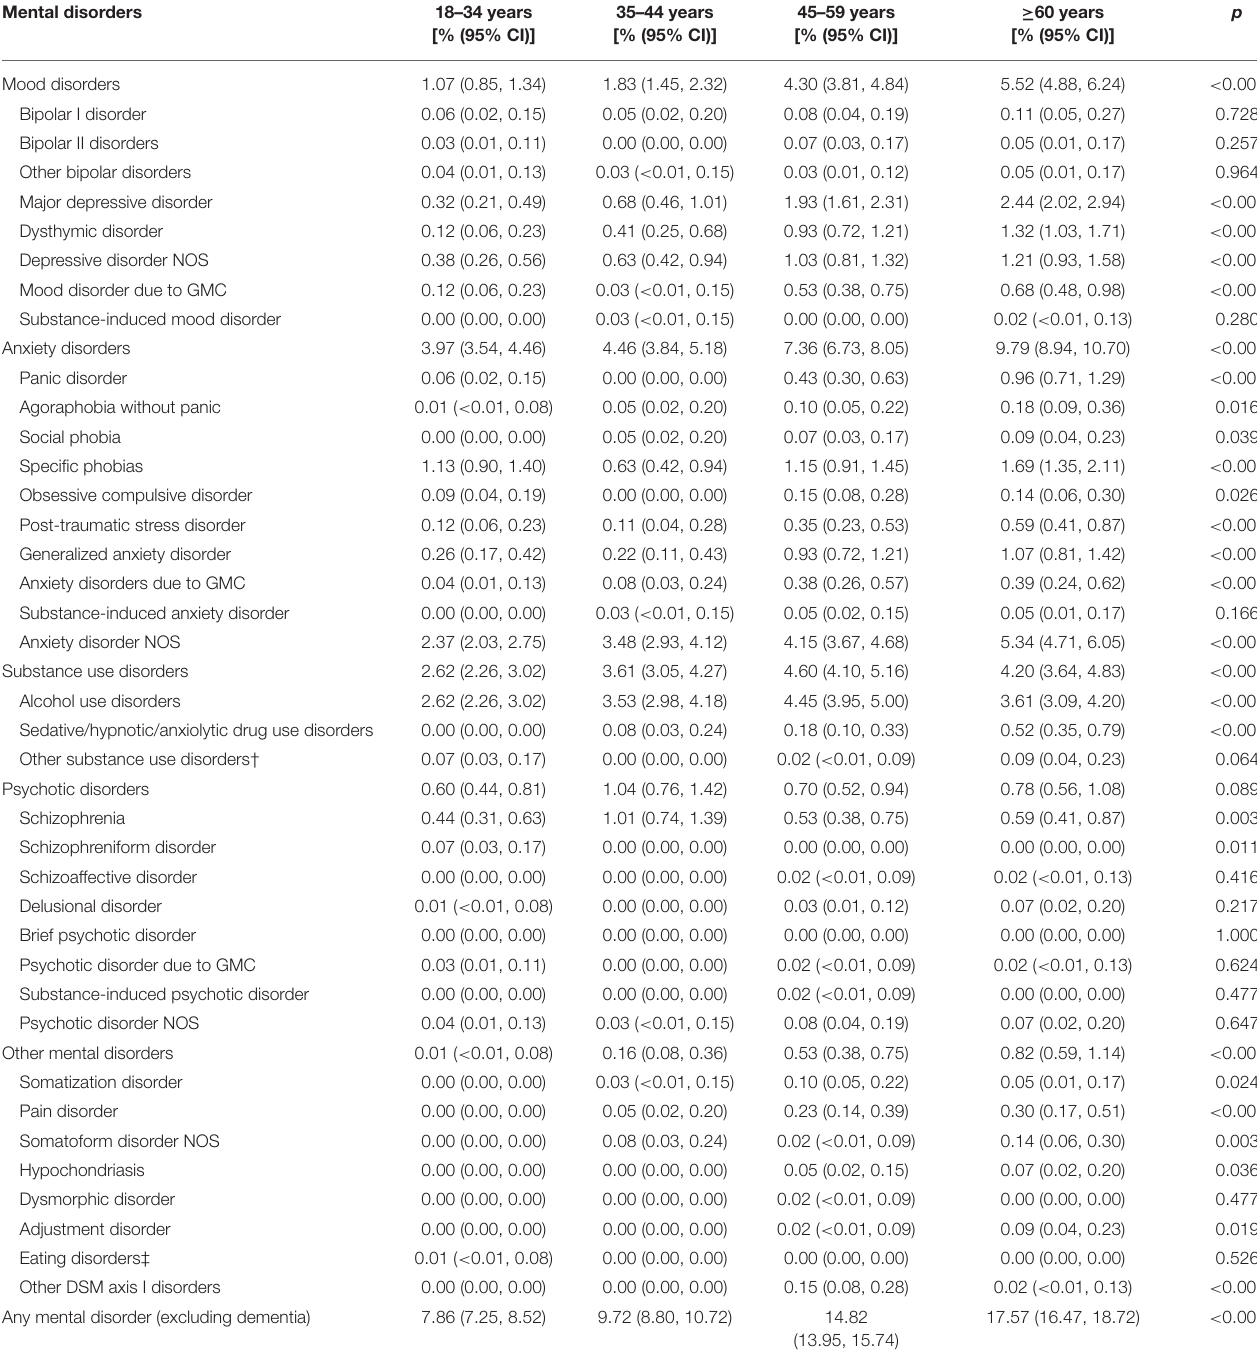
TABLE 5 | Weighted 1-month prevalence of mental disorders by age in Hebei province, China ( n =